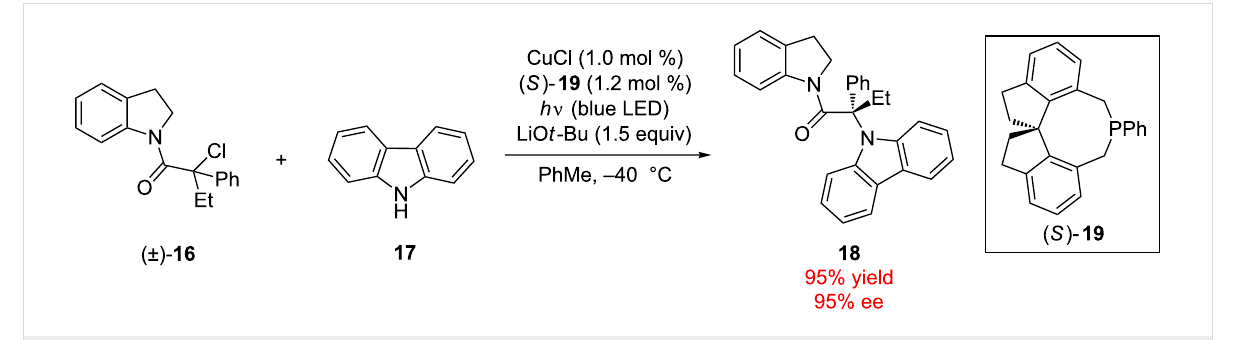
Scheme 3: Stoltz’ stereoablative oxindole